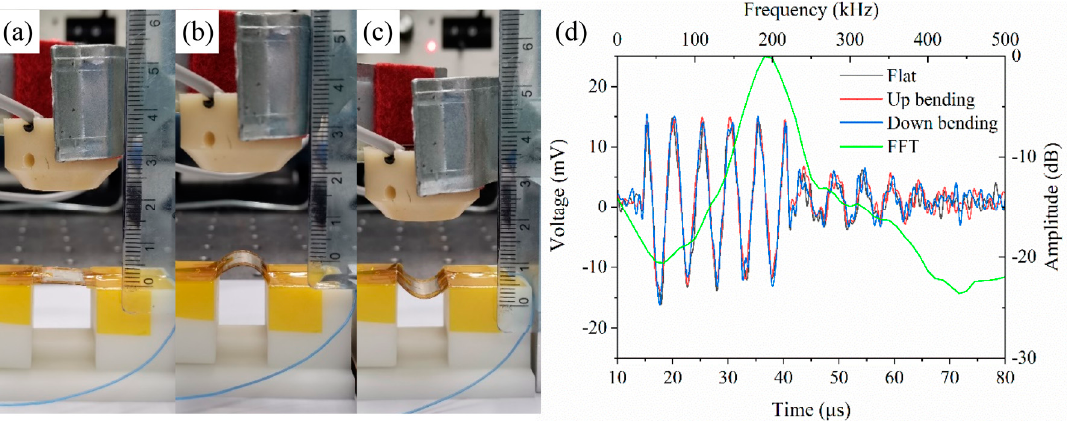
Figure 17. The PMUT served as a transmitter in flat state ( a ), up bending state ( b ), and down bending state ( c ). ( d ) The receiving signals and the FFT spectrum. state ( c ). ( d ) The receiving signals and the FFT